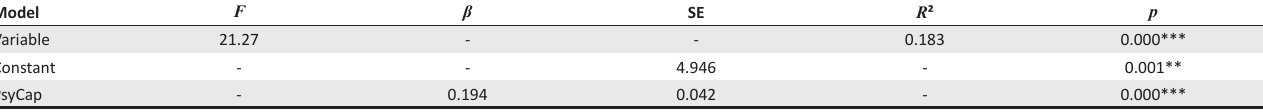
TABLE 5: Simple linear regression (psychological capital and continuance organisational commitment). Model